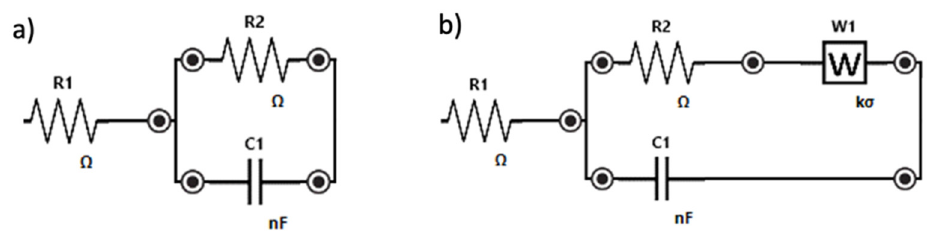
Figure 3. Randles equivalent circuit of ( a ) MIP-modified electrode, ( b ) bare electrode.